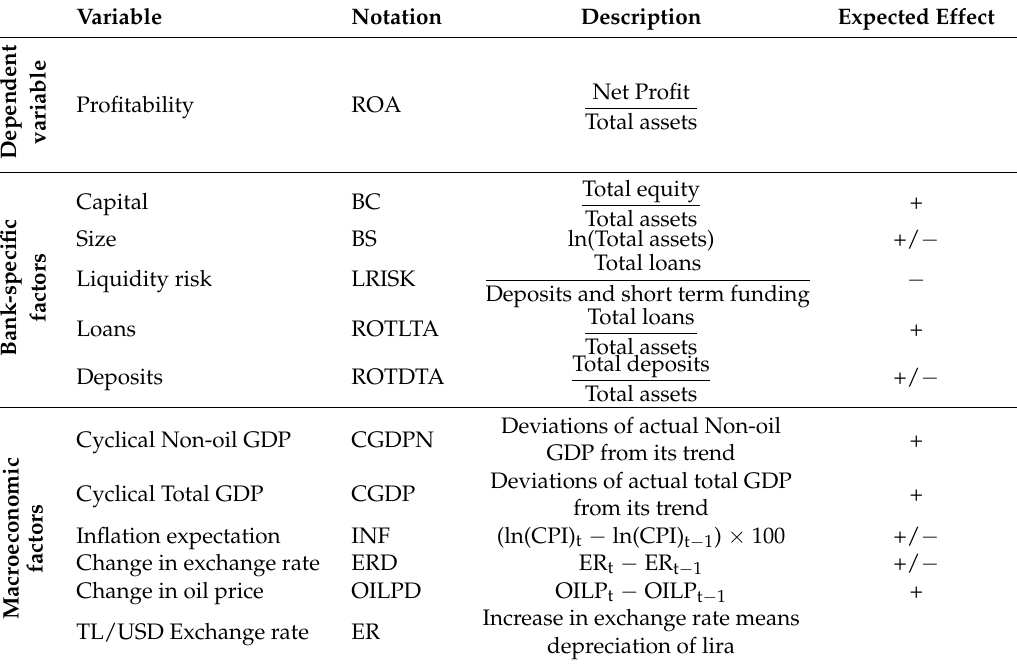
Table 1. Variables used in the empirical